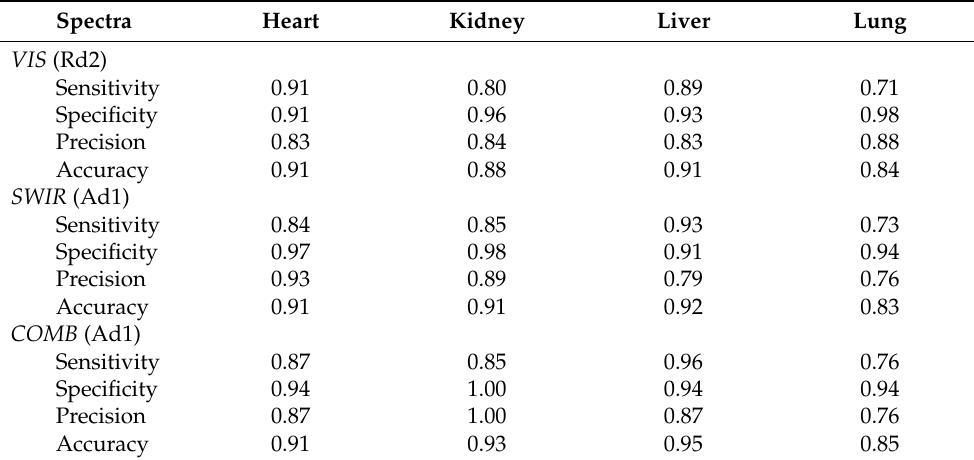
Table 7. Random forest model metrics per organ for visible (VIS), short-wave infrared (SWIR) and combination VIS and SWIR (COMB) hyperspectral sensors on the in-sample dataset.